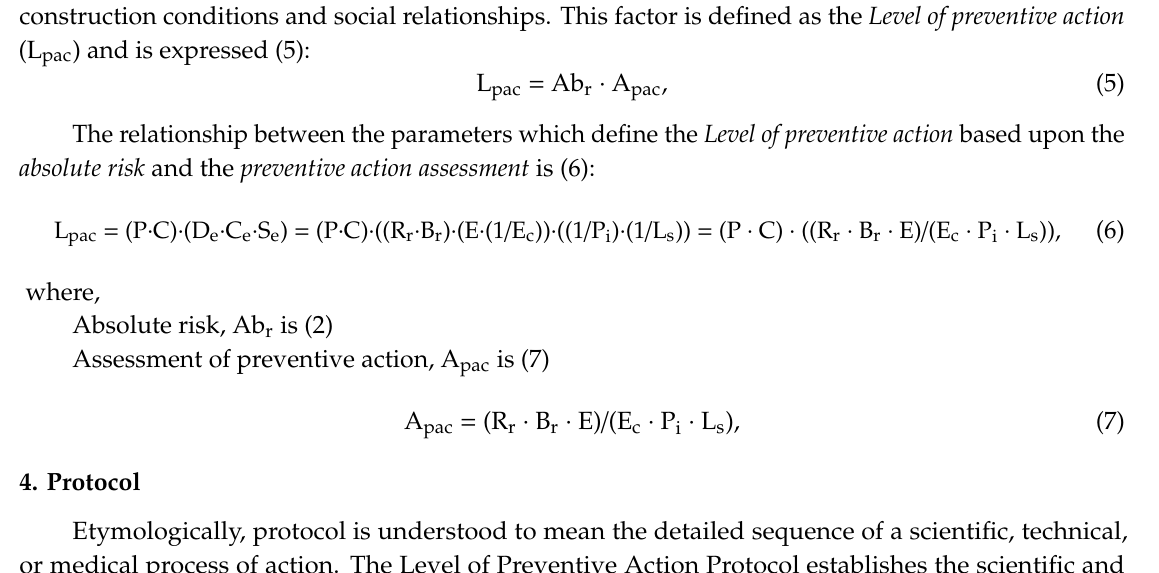
Table 2. Risk estimation qualitative values Risk Estimation